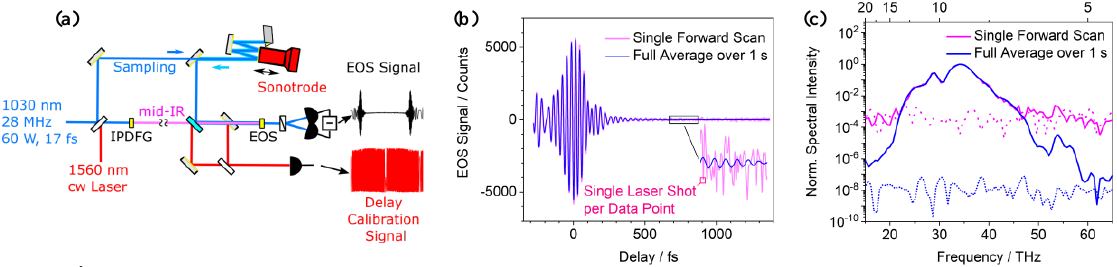
Fig. 1. ( a) Schematic diagram of the experimental setup. (b) Comparison of a single EOS scan mapping the electric field of the mid-infrared pulse with the mean of all traces acquired over 1s (i.e., 38000 scans). (c) Mid-IR intensity spectra obtained by Fourier transformation of the traces in (b) (Dashed lines represent baseline